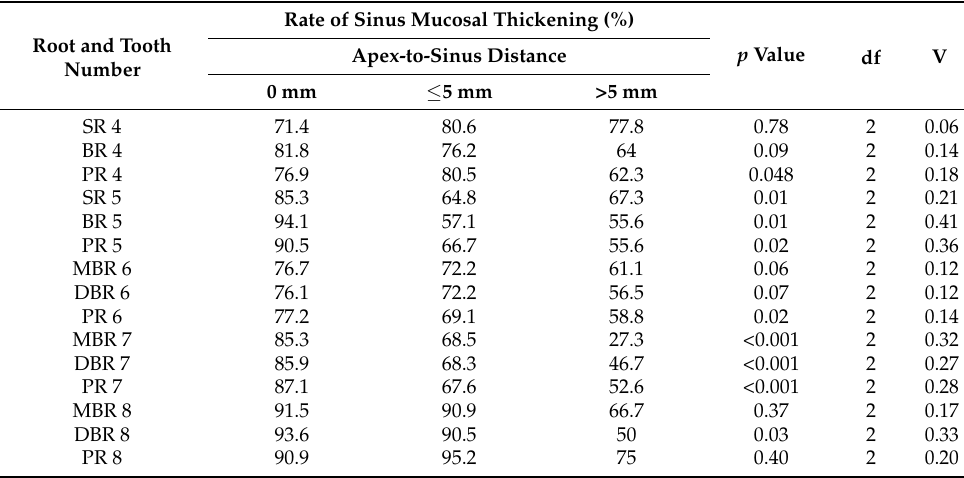
Table 2. The effect of the distance between the root tips and the sinus floor on the rate of sinus mucosal thickening.